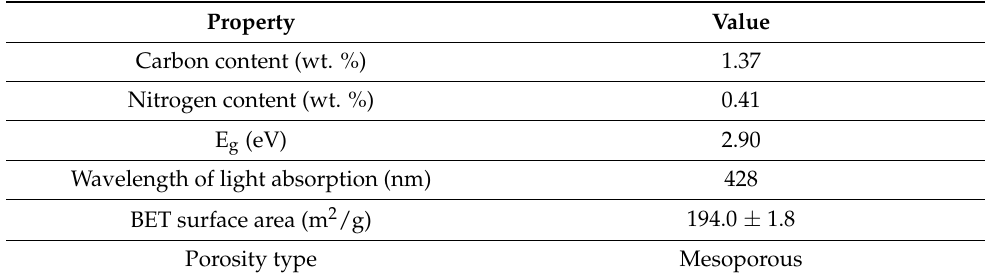
Figure 2. ( a ) XRD pattern, ( b ) FTIR spectrum, and ( c , d ) FEG − SEM micrographs of the C,N − TiO 2 semiconductor. Table 2. Properties of the C,N-TiO 2 semiconductor.